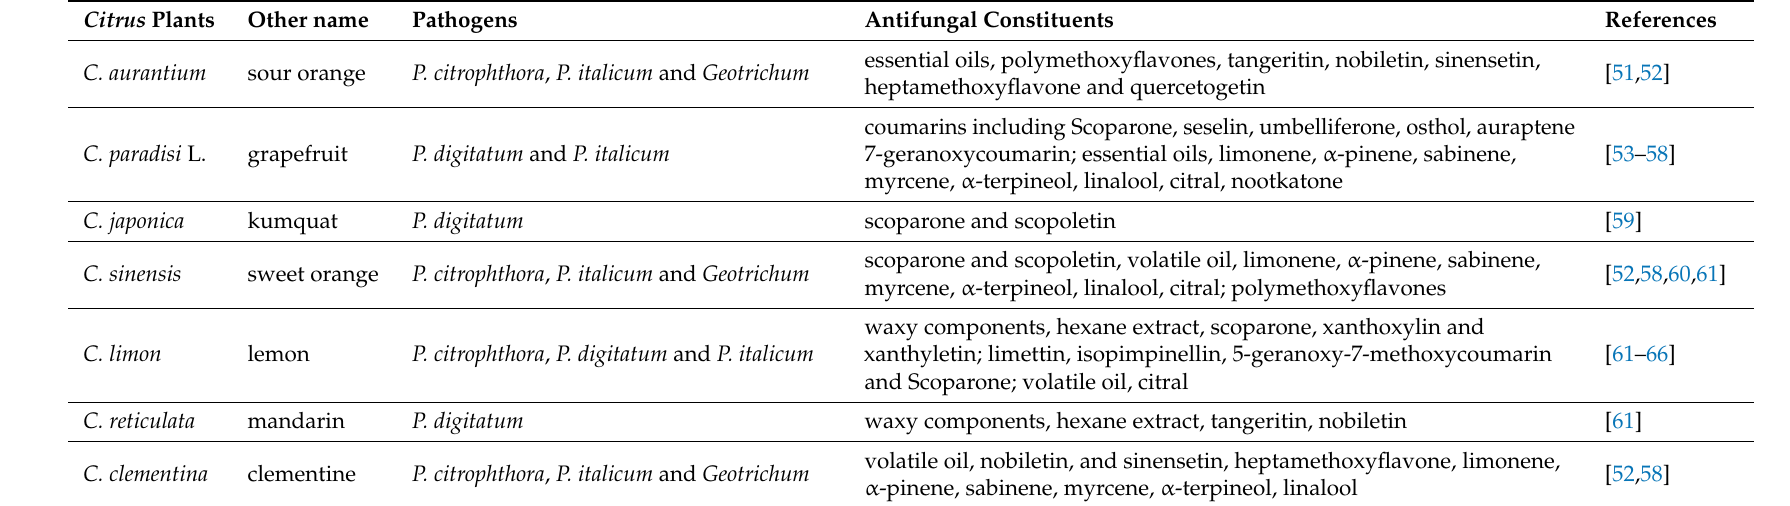
Table 2. Inhibitory activity of Citrus extracts on P. digitatum and P.